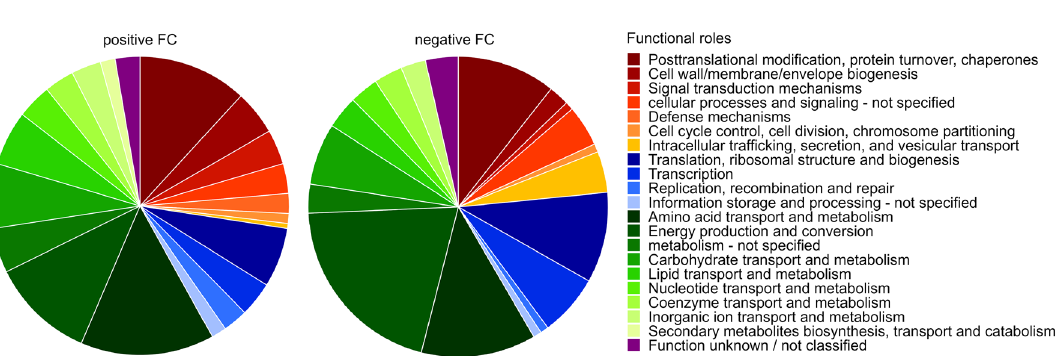
Figure 6. Functional shifts in bacterial protein groups (PGs) between aphelid-infected (AI) and non-infected (NI) S. vauolatus cultures with significantly upregulated (Fold changes (FC) > 1.5, left) and downregulated (FC < − 1.5, right) PGs. PGs were categorized into functional groups (green: metabolism; blue: transcription/ translation; red: posttranslational modification, for details see figure legend) based on EggNOG database by Prophane. Relative proportions of each functional role were determined to be more (197 proteins) or less abundant (226 proteins) in AI treatment compared to NI